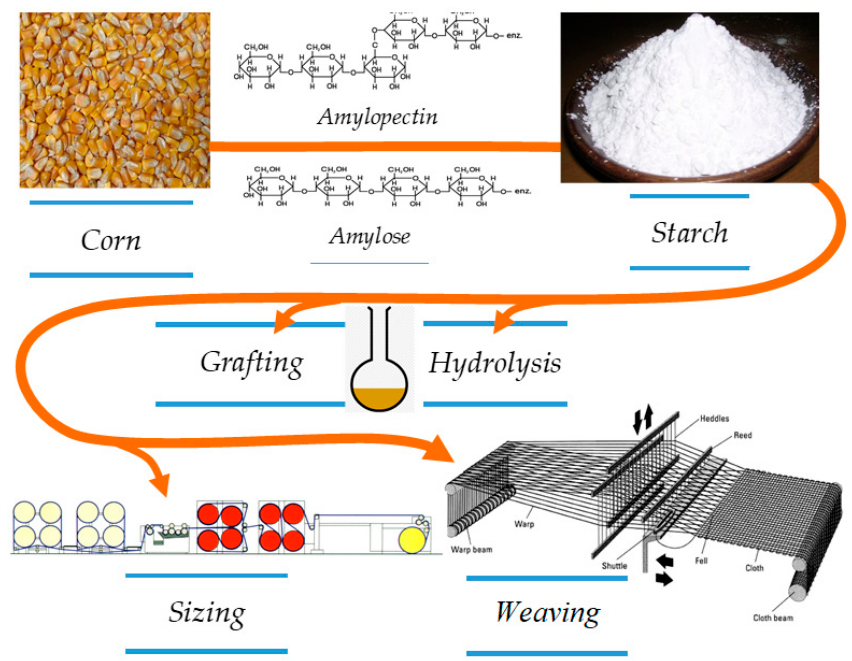
Figure 1. Preparation procedure of hydrolysed and grafted corn starch, sizing and weaving process.